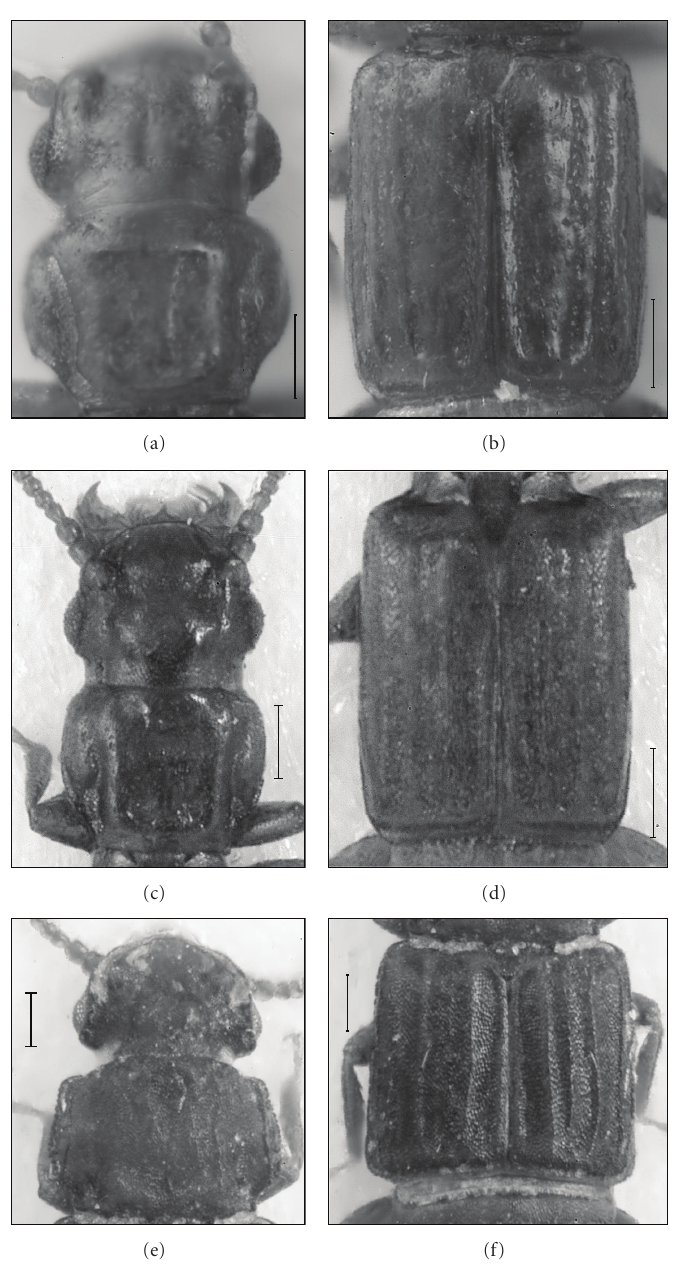
Figure 4: Surface of head, pronotum (a) and elytra (b) of Thoracophorus simplex ; surface of head, pronotum (c) and elytra (d) of T. venezuelanus ; and surface of head, pronotum (e) and elytra (f) of T. silvaticus (scale bar: 0.1 mm).